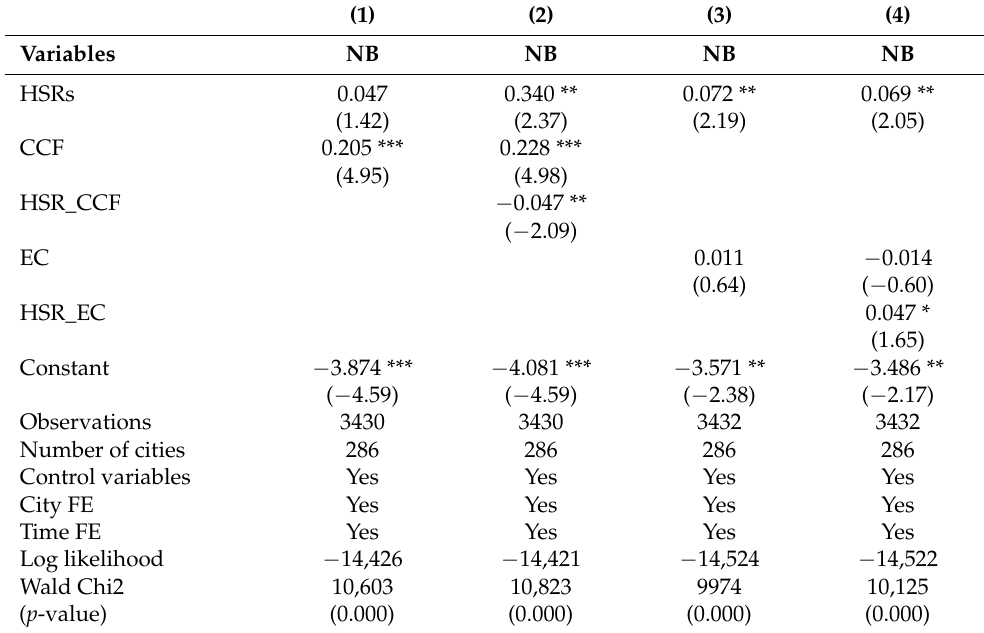
Table 5. Mechanism